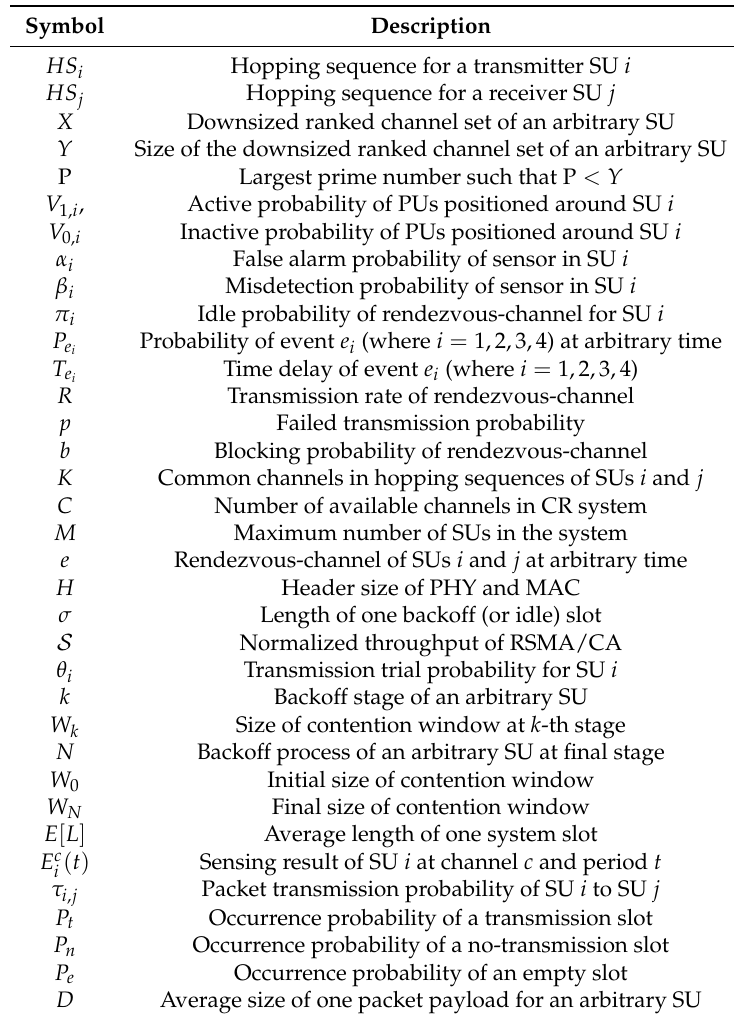
Table 2. Summary of the